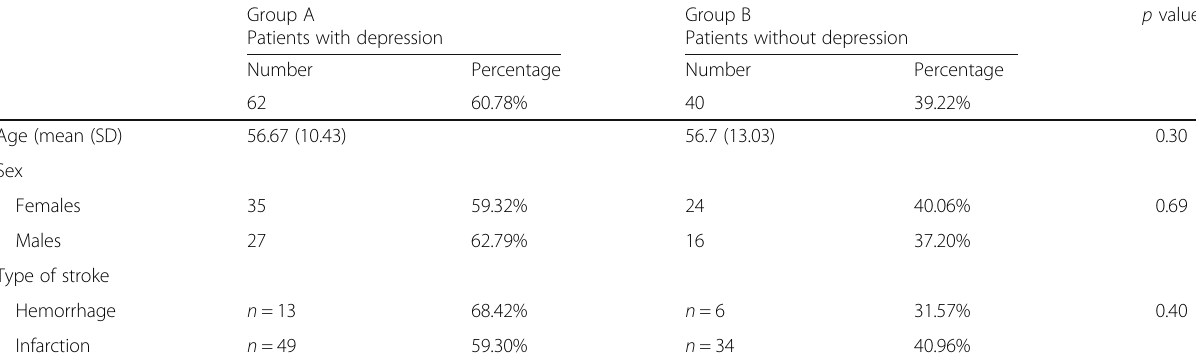
Table 1 Demographic data and type of stroke in both groups